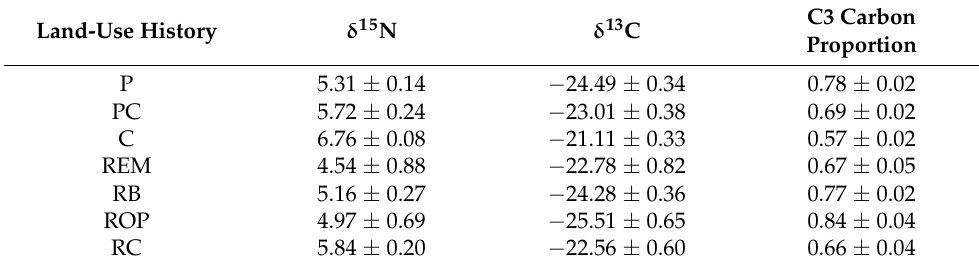
ROP restoration soil contained greater proportions of C3 carbon than soil in RC restorations ( p = 0.02), row crop fields ( p = 0.002), and remnant prairies ( p = 0.04). Bison prairie soil also contained greater proportions of C3 carbon than row crop field soil ( p = 0.04) as did P pastures ( p = 0.04), but PC pastures and row crop fields were